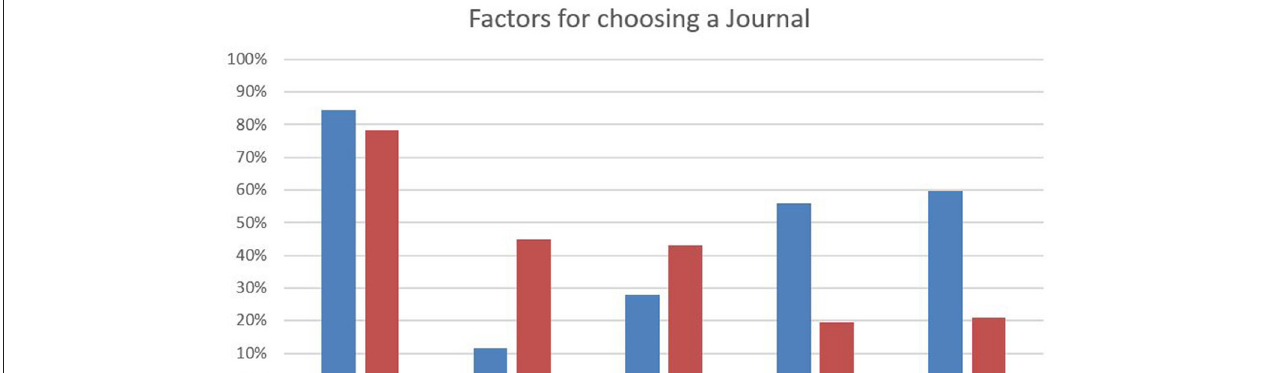
FIGURE 4 | Publication types.